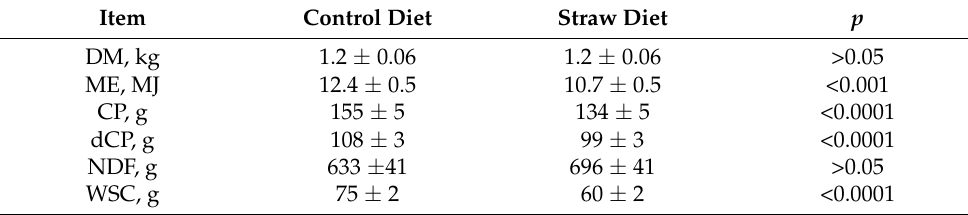
Table 3. Intake of dry matter (DM), metabolisable energy (ME), crude protein (CP), digestible crude protein (dCP), neutral detergent fibre (NDF) and water soluble carbohydrates (WSC) per 100 kg body weight and day (LSmeans ± SE) in six horses fed a diet with 50% wheat straw and 50% grass haylage (DM basis) and a control diet without straw (grass haylage only) in a 2 × 21-day cross-over design. Item Control Diet Straw Diet p DM, kg 1.2 ± 0.06 1.2 ± 0.06 >0.05 ME, MJ 12.4 ± 0.5 10.7 ± 0.5 <0.001 CP, g 155 ± 5 134 ± 5 <0.0001 dCP, g 108 ± 3 99 ± 3 NDF, g 633 ±